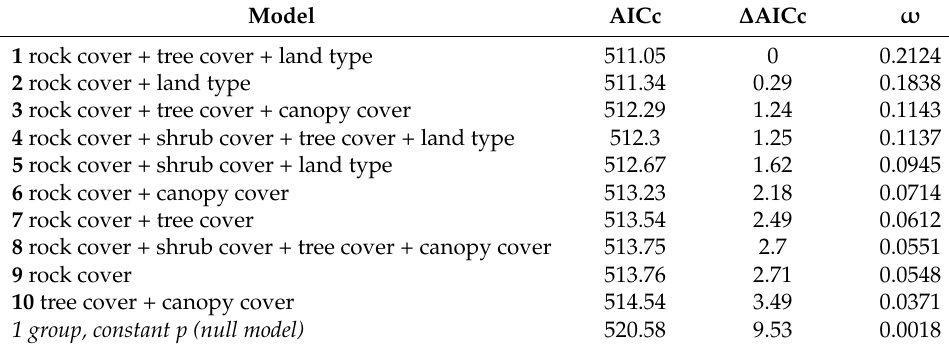
Figure 1. Locations of S. occidentalis survey transects. Open circles indicate transects where lizards were not observed on any visit, whereas circles with black centers indicate transects where lizards were observed on at least one visit. The upper map shows the boundary of the Los Padres National Forest (green), as well as streams across the study area (blue). The lower map shows the distribution of canopy cover across the study area, with the dark to light green gradient reflecting a continuum of high to low canopy cover. Table 1. Top 10 models for S. occidentalis occupancy across the urban–rural gradient in Santa Barbara, California. AICc values, change in AICc values relative to the top model, and AIC weights ( ω are shown. Data are also provided on the null model with no